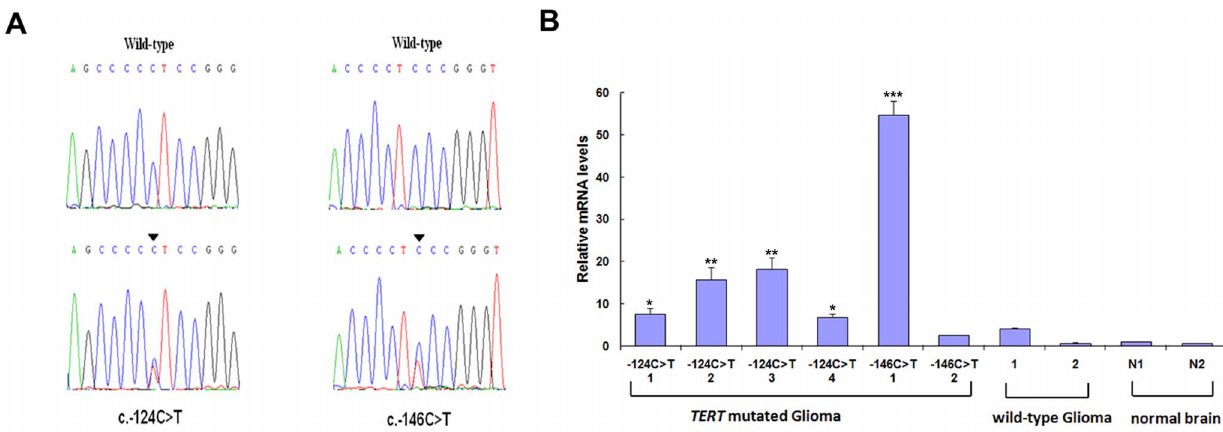
Figure 1. TERT promoter mutation and mRNA expression. A: DNA sequence chromatograms of glioma tissue samples with mutations in the TERT promoter. Single nucleotide transitions (C . T) were observed at 2 124 bp or 2 146 bp from the ATG translation start site of the TERT gene. B: Detection of TERT mRNA levels in glioma tissue samples with and without TERT promoter mutations, and in two normal brain tissue samples. Gliomas with mutations include four samples with the 2 124 C . T mutation, and two with the 2 146 C . T mutation. Wild-type gliomas lacked mutations in TERT promoter region. N1 and N2 are normal brain tissues. TERT gene expression was significantly higher in mutated TERT promoter glioma samples compared to normal tissue samples, while this was not observed in wild-type TERT promoter glioma samples. The reference, N1, was considered as having a value of one. * P , 0.05; ** P , 0.01; *** P , 0.001 (compared with N1).